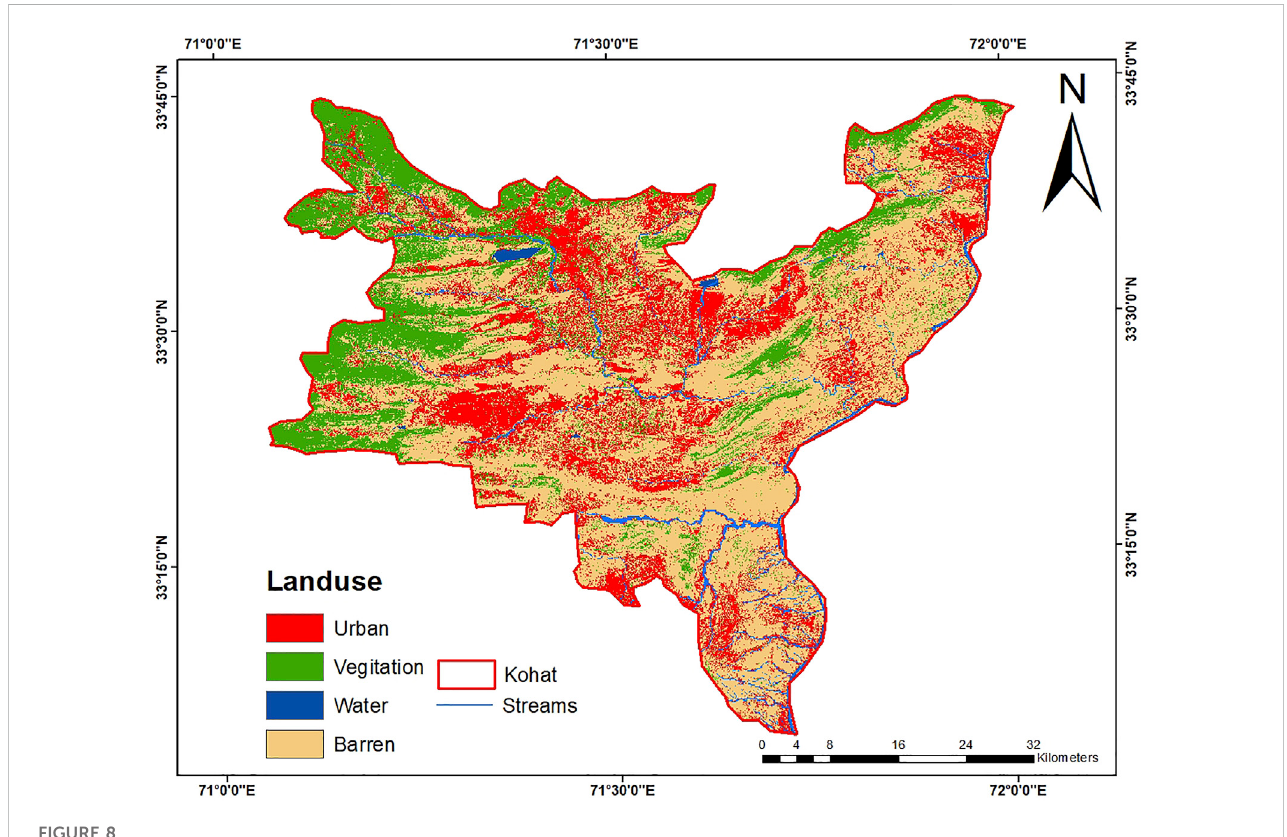
FIGURE 8 Land use map of the study